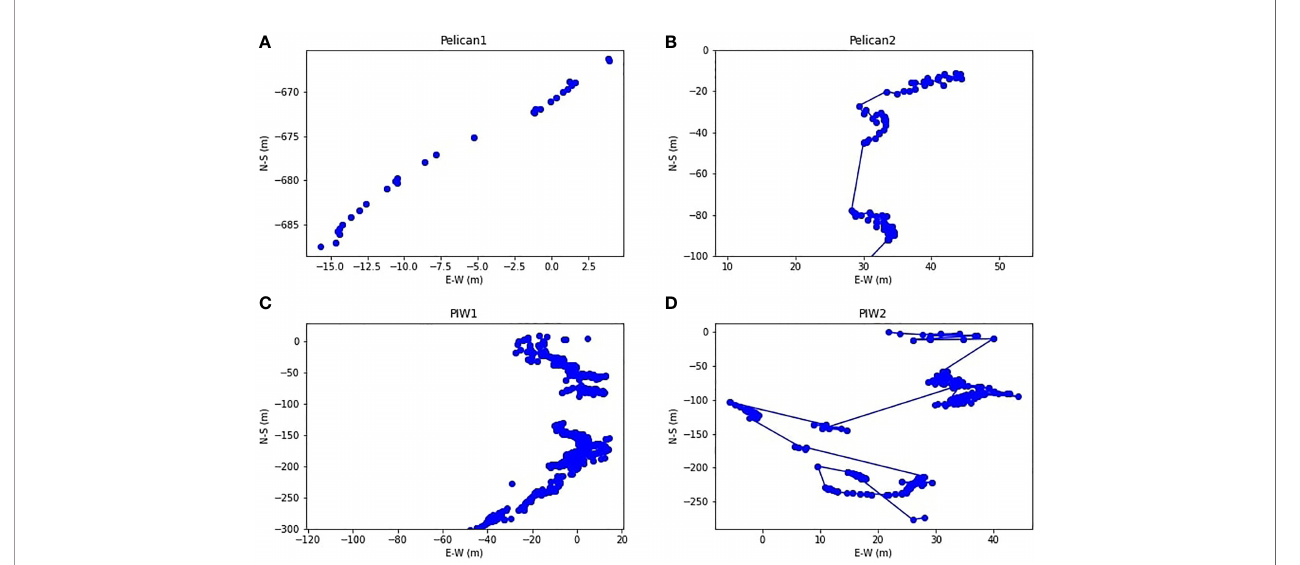
FIGURE 11 | Trajectory of (A) Pelican 1 in m (B) Pelican 2 in m, (C) PIW 1 in m. (D) PIW 2 in m.